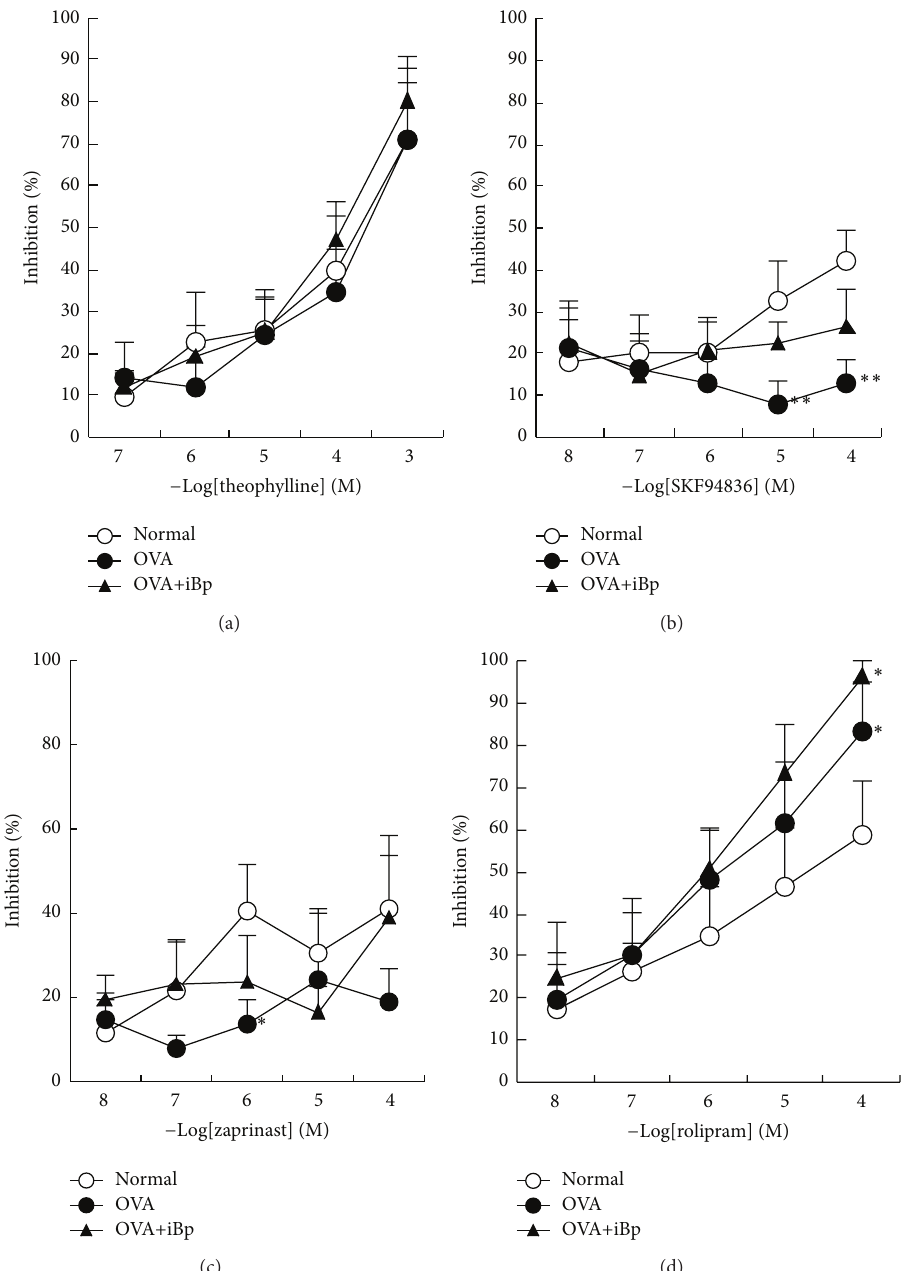
Figure 3: Inhibitory effects (%) of theophylline (a), SKF94836 (b), zaprinast (c), and rolipram (d) on the cAMP-PDE activity in the lung homogenates harvested from OVA+iBp and OVA rats (mean ± SEM; ∗ 𝑃 < 0.05 ; ∗∗ 𝑃 < 0.01 versus